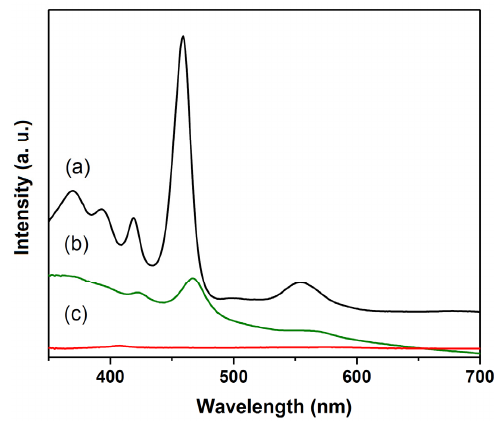
Figure 8. UVVIS spectra: ( a ) Methanolic MnP solution; ( b ) Solid Nujol emulsion of MnP-LDH3; ( c )